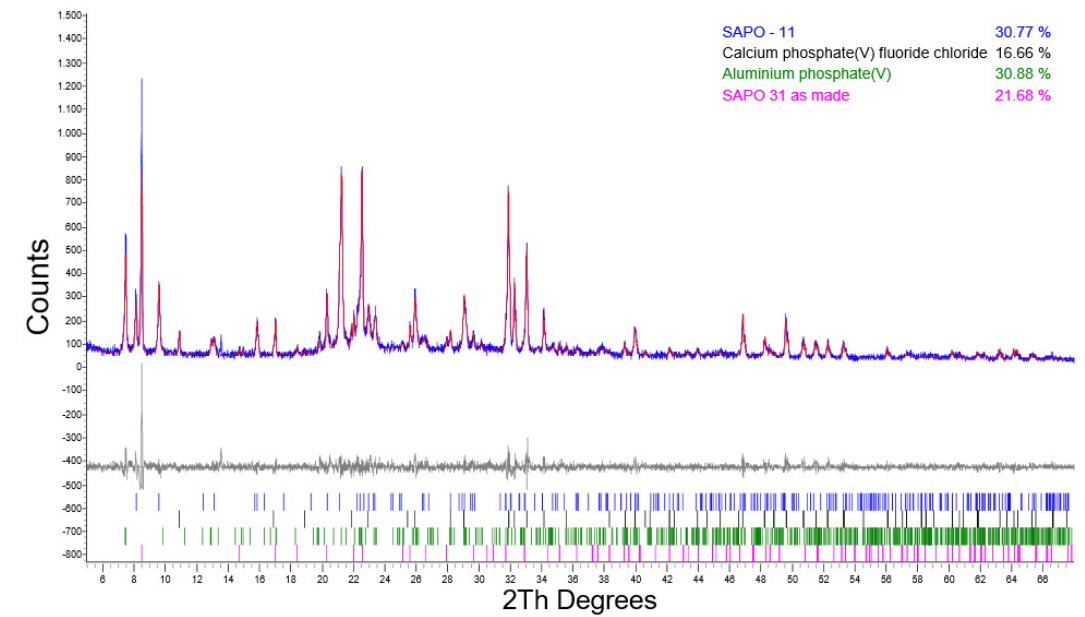
Figure A3. Rietveld refinement plot for 24/SHR0.5: the vertical lines provide the positions of all possible Bragg reflections for the aluminum phosphate(V) phases (database_code-ICSD 88566), calcium phosphate(V) fluoride chloride (database_code-ICSD 203026), structure of zeolite type AEL (database_IZA), and end structure of zeolite type ATO (database_IZA). The values of the standard agreement indices are Rp—10.74, Rwp—13.99, Rexp—10.77, GofF—1.30.4.